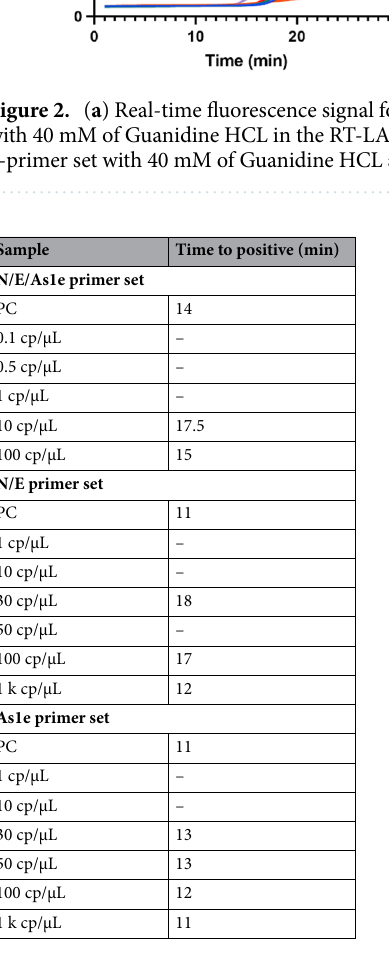
Table 2. Time to positive amplification of respective genes using the different primer sets. Time to positive was calculated as being the sum of the average non-template control (NTC) RFU with 3 times the standard